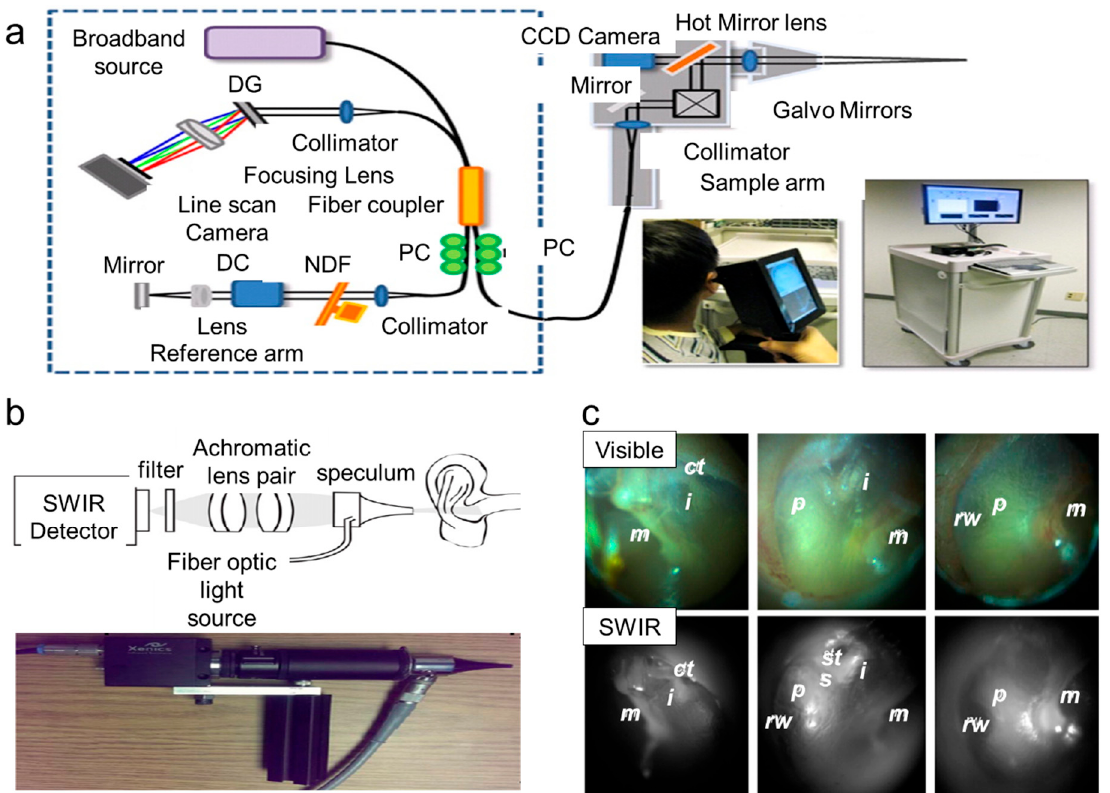
Figure 5. Tools available to detect middle ear infection. ( a ) Handheld OCT (optical coherence tomography) (diffraction grating (DG); polarization controller (PC); dispersion compensation (DC) materials; neutral density filter (NDF)). Reproduced with permission from [76]. Copyright Elsevier B.V.,2013. ( b ) SWIR (short wavelength infrared) otoscope. Reproduced with permission from [81]. Copyright National Academy of Sciences,2016 ( c ) Representative images for ( b ) Reproduced with permission from [81]. Copyright National Academy of Sciences,2016. ct, chorda tympani; i, incus;